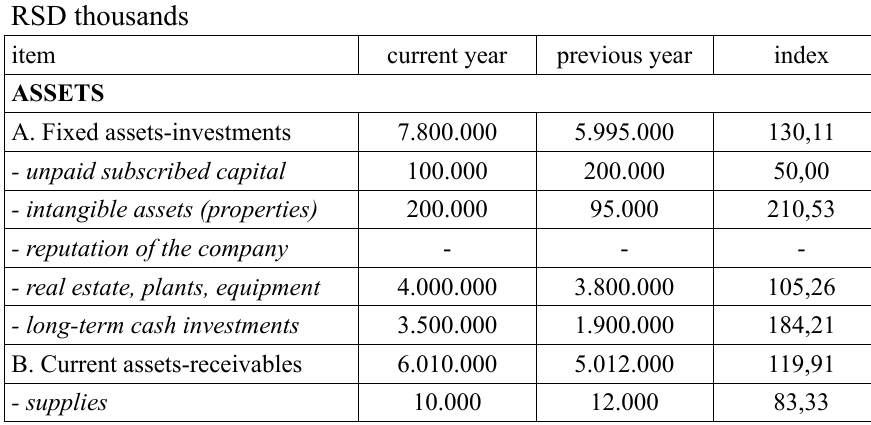
Table 1. Simplified layout of the the insurer’s balance sheet. 4 (as of 31 st December,